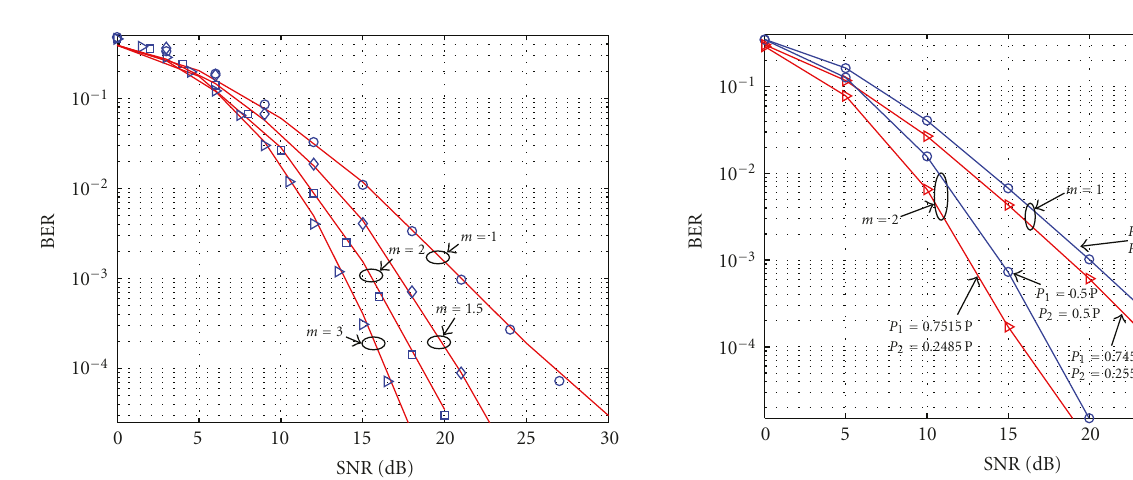
= σ 2 = 1, and s , r s , d